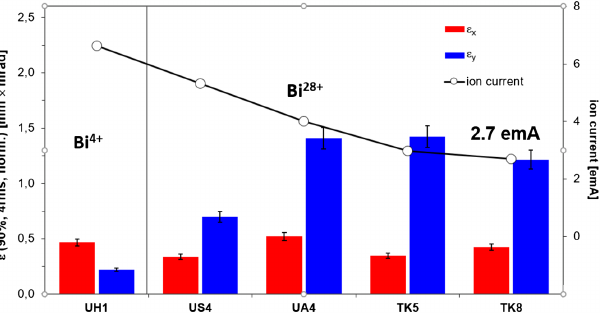
FIG. 7. Evaluation of high-intensity 209 Bi-beam emittance measurements corresponding to Fig. 6.